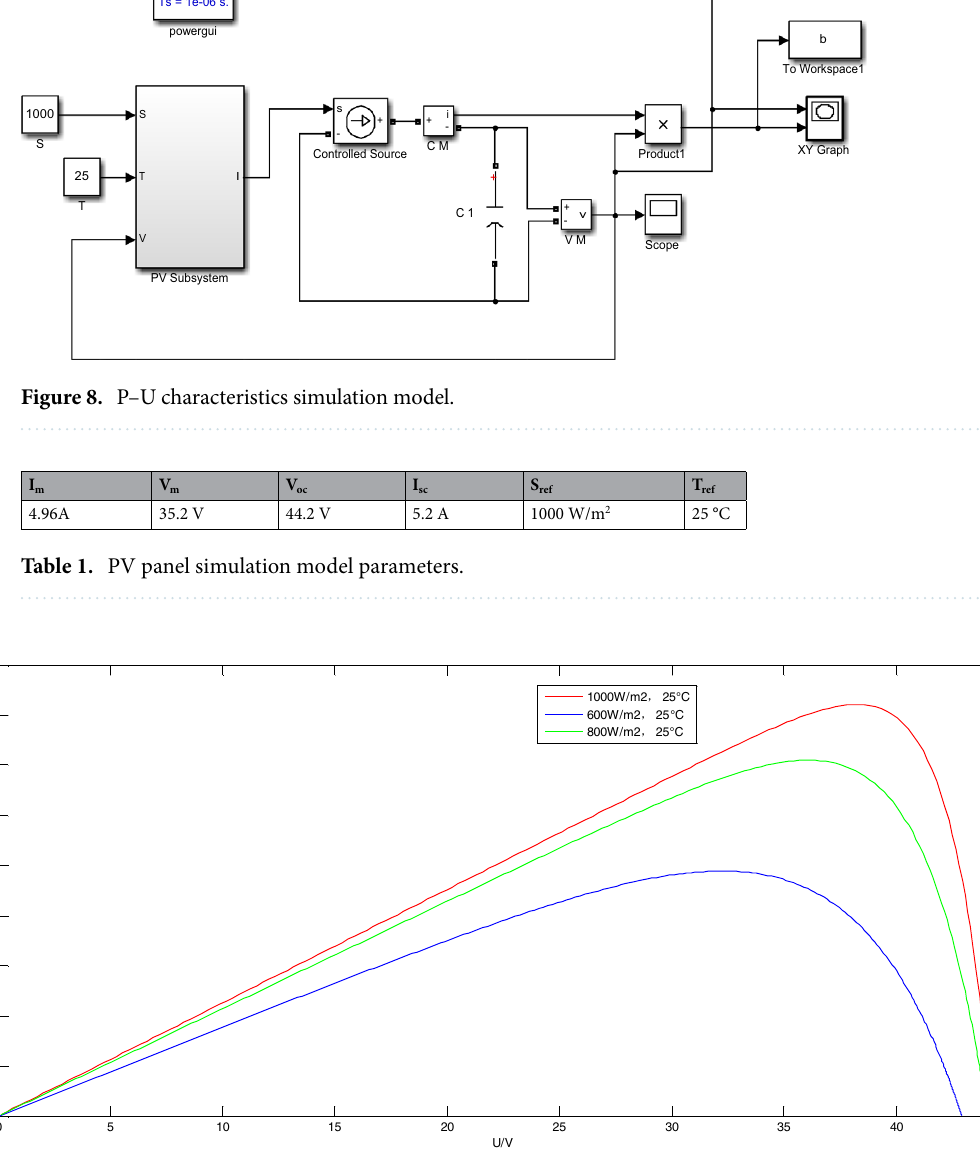
Figure 9. The P–U characteristic curve under different light intensities.